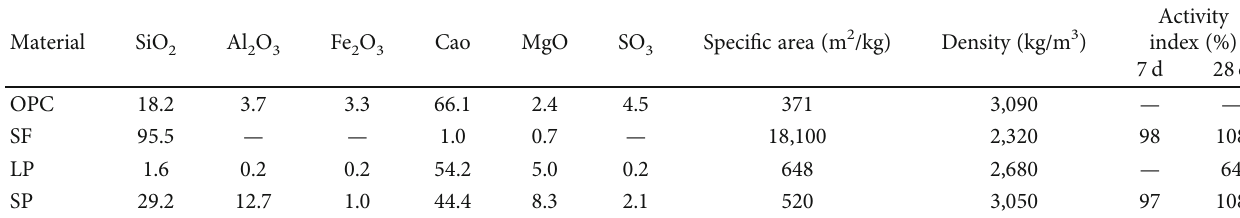
Table 1: Chemical composition and physical properties of OPC, SF, LP, and SP.